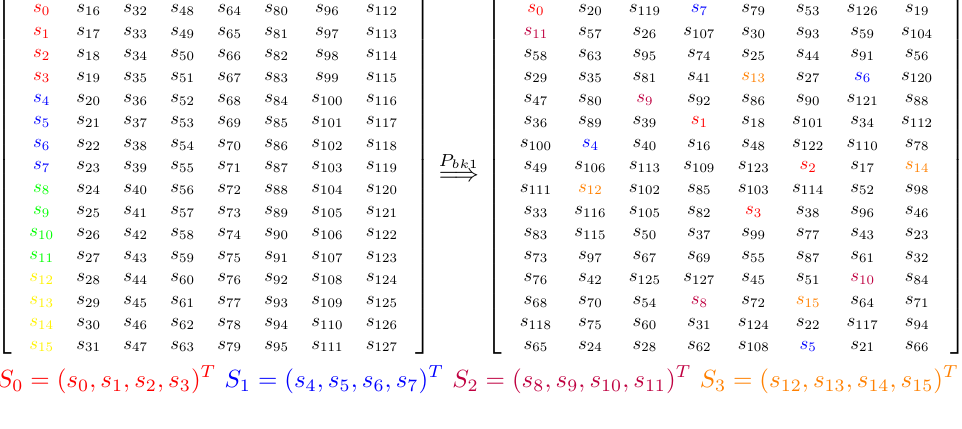
Figure 10: Transition of a state after applying P bk 1